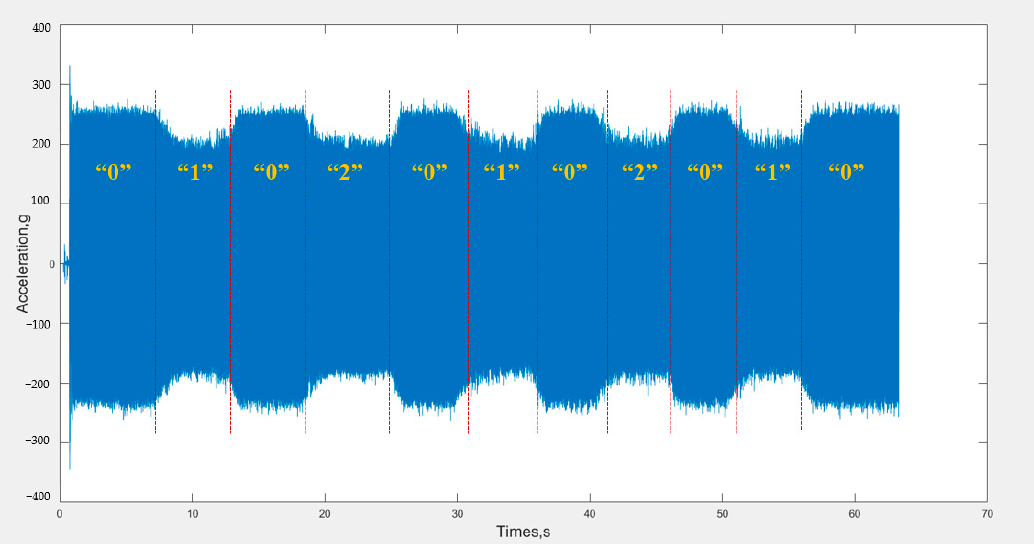
Figure 10. Time domain diagram of the acceleration signal. Table 4. Statistical table of classification